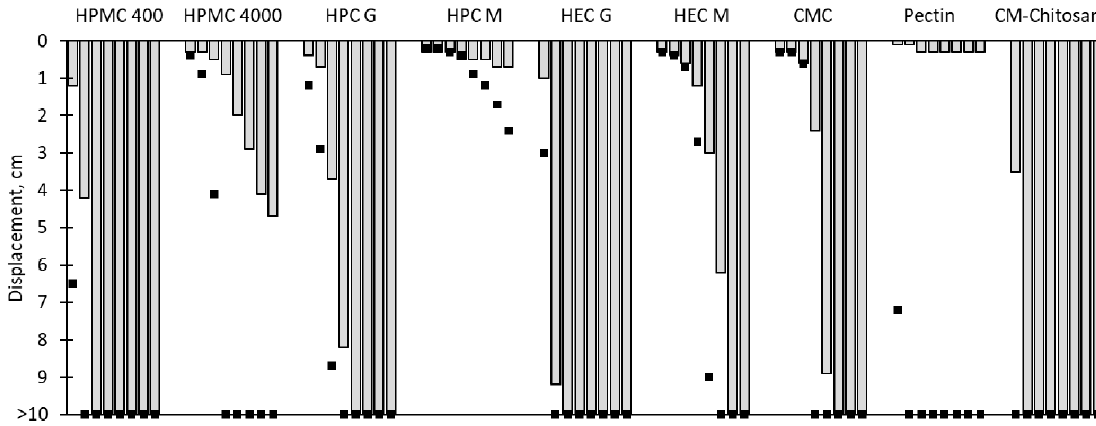
Figure 4. Displacement of powder samples on agar–mucin gels (bars) and pure agar gels (dots) after 0.5, 1, 2, 3, 4, 5, 6, and 7 h (from left to right). n = 3; the maximal displacement is shown.